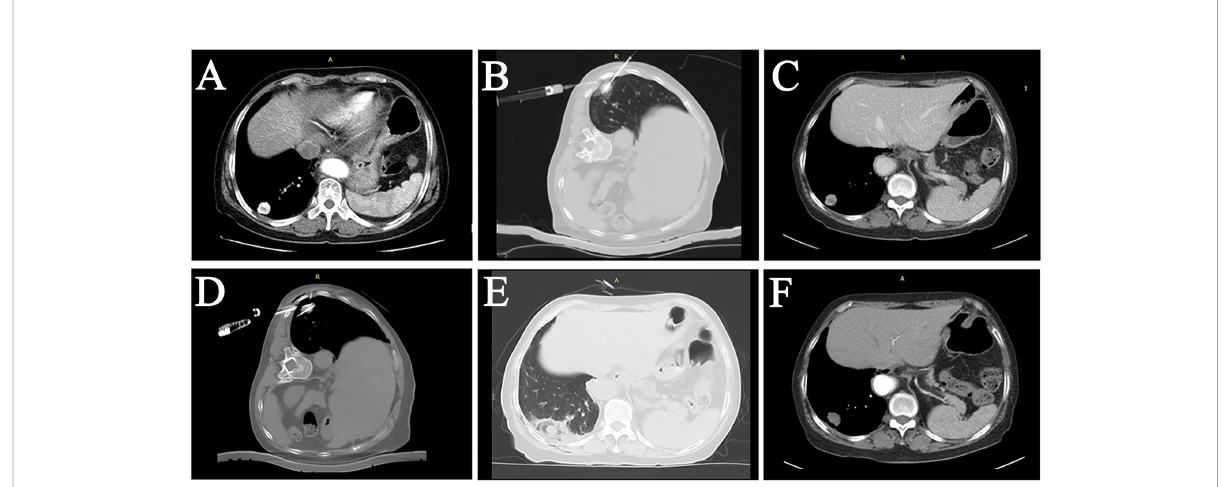
FIGURE 3 A female patient, 72 years old, with lung adenocarcinoma in the right lower lung lobe, underwent secondary ablation after the fi rst incomplete ablation. (A) The tumor was located in the subpleural area with signi fi cant enhancement. (B) First MWA treatment combined with LPA. (C) Follow-up CT three months after the intervention showed signi fi cant inhomogeneous enhancement within the tumor. (D) Re-ablation of the tumor was performed using two MWA antennas combined with LPA. (E) Postoperative CT showed a “ halo sign ” surrounding the tumor. (F) 3-month follow-up after the secondary ablation indicated complete tumor